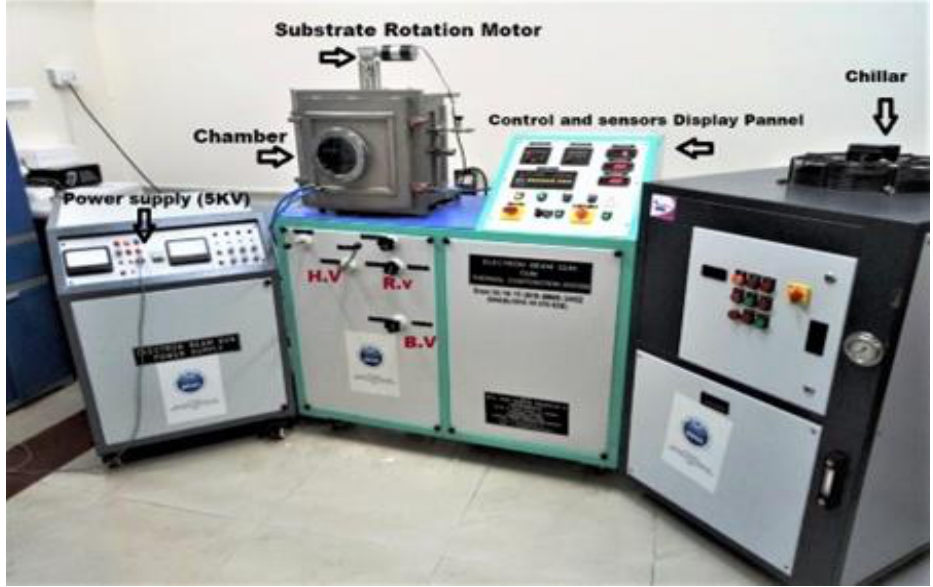
Figure 8. Complete set up of Deposition Machine.